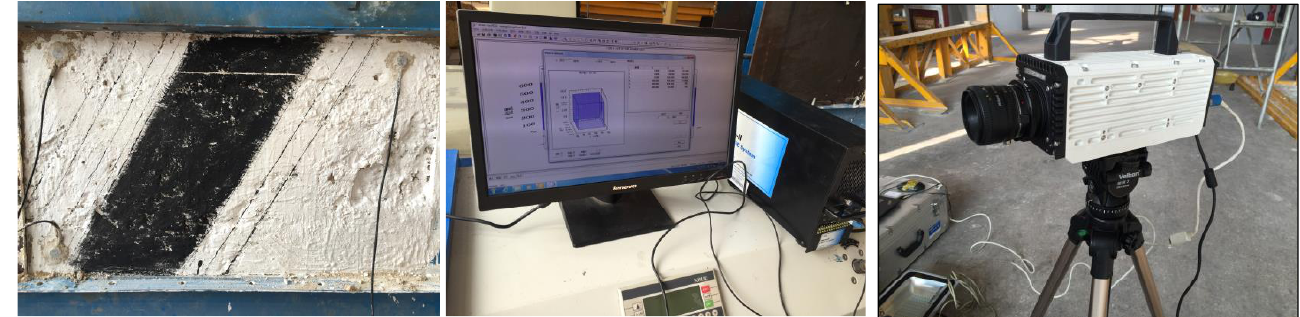
Figure 4. Acoustic emission and high-speed camera acquisition system.